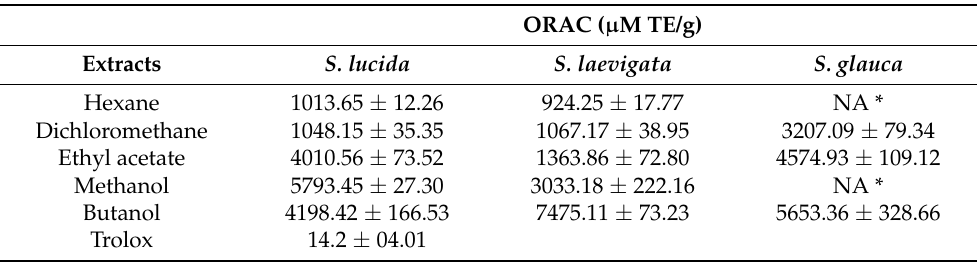
Figure 2. Bar chart of ORAC values of extracts from S. lucida , S. laevigata , and S. glauca. Table 1. Oxygen radical absorbance capacity (ORAC) activities of S. lucida, S. laevigata, and S. glauca extracts.